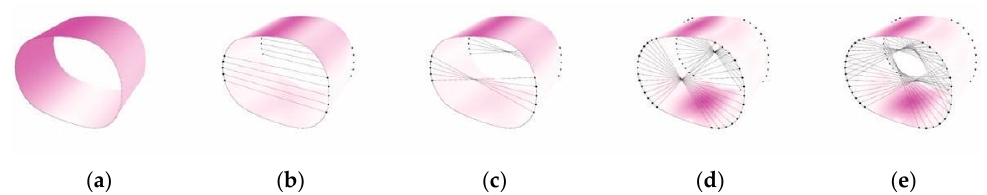
Figure 11. Timber surface deflection analysis: ( a ) no FRP winding applied; ( b ) in-plane winding, no fibre interaction; ( c ) in-plane cross-winding; ( d ) denser syntax, in-plane cross-winding; ( e ) alternating edge cross-winding with many points of fibre interaction.